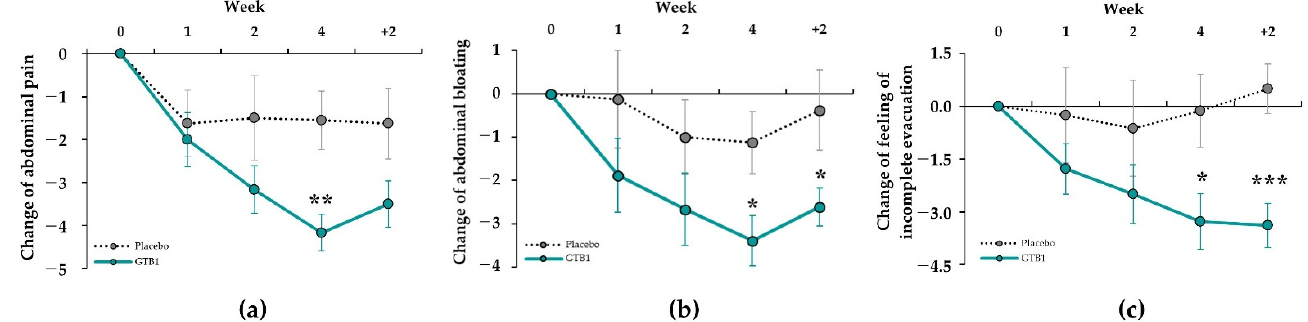
Figure 3. Change in severity of intestinal discomfort symptoms in GTB1 and placebo groups after one, two, and four weeks and follow-up week two. ( a ) Abdominal pain; ( b ) abdominal bloating; ( c ) feeling of incomplete evacuation. Differences were compared between each follow-up time point and before baseline. Data are means ± SEM. * p < 0.05, ** p < 0.01, *** p < 0.001 as determined by Wilcoxon rank-sum test or by two-sample t -test.